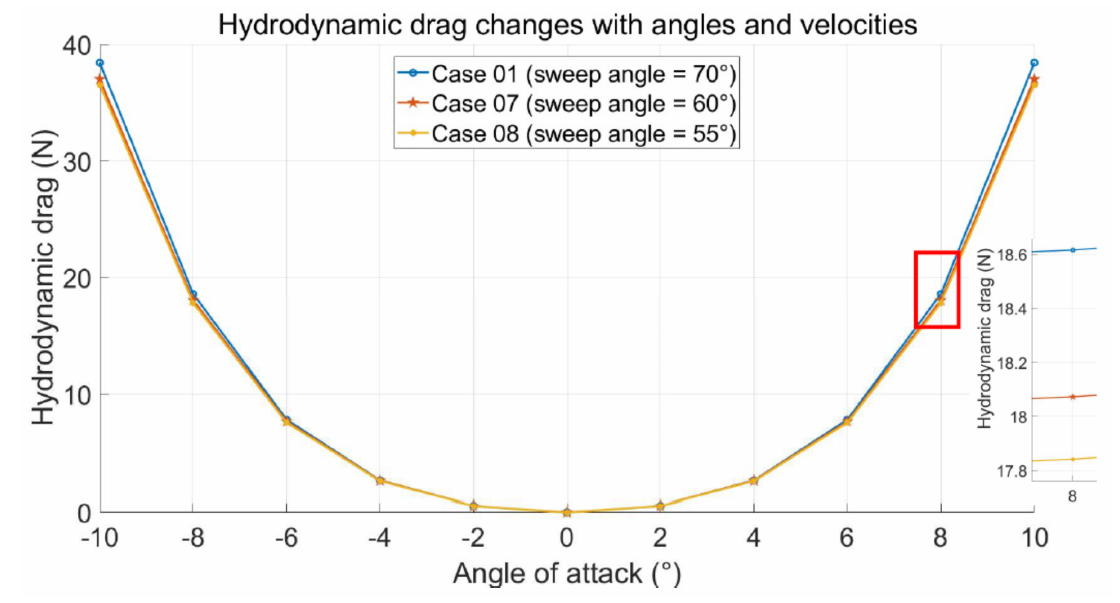
Figure 11. Changes in the hydrodynamic drag with angles and velocities.